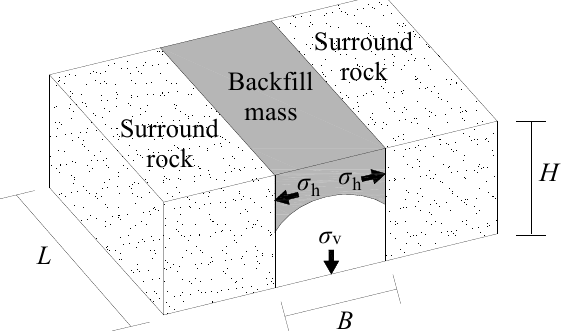
Figure 1. Schematic diagram of the arching e ff ect (B: Stope width; L: Stope length; H: Layer height).